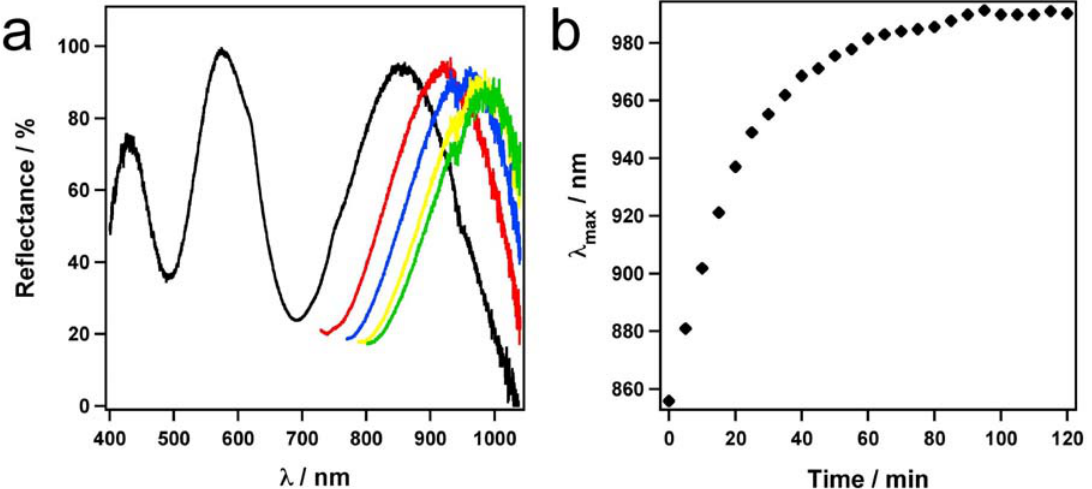
Figure 9. ( a ) Reflectance spectra over time after introduction of a 3 mg/mL glucose solution to an etalon constructed with APBA modified microgels. The black line represents the initial spectrum, the red, blue, yellow, and green lines represent the spectrum after 15, 30, 60, and 120 min respectively. ( b ) Plot of the high wavelength peak position in (a) as a function of time after glucose addition. Total spectral shift is ~134 nm.